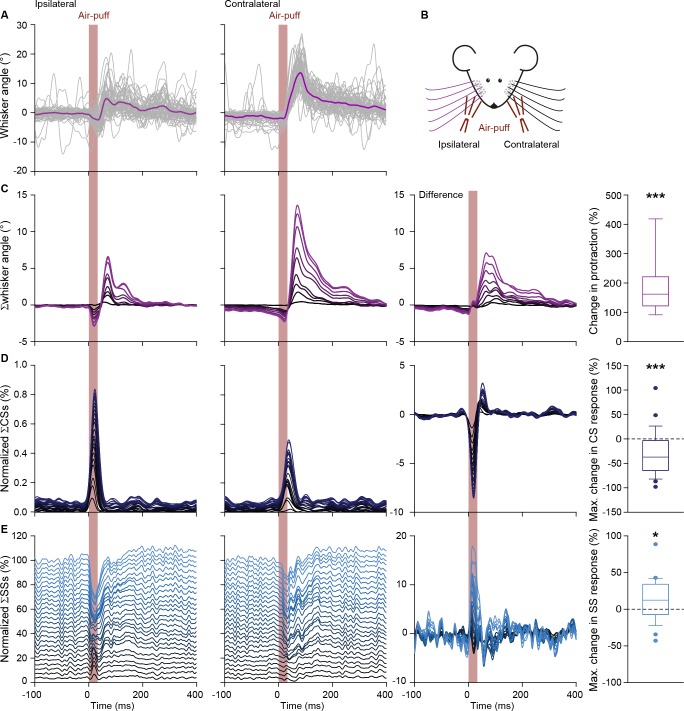
Contralateral whisker pad stimulation induces stronger whisker protraction and stronger simple spike responses.(A) Whisker traces of a representative mouse following air-puff stimulation of the ipsilateral (left panel) and contralateral (right panel) whisker pad (see scheme in B). Despite a similar strength of stimulation, the protraction of the whiskers was larger upon contralateral stimulation (cf. Figure 1—figure supplement 2). (C) Stacked line plots of the averaged whisker traces of 9 mice with the difference between the contralateral and ipsilateral stimulation depicted in the third column. (D) Complex spike responses, on the other hand, were more prominent upon ipsilateral stimulation. (E) The observation that increased simple spike firing correlates to enhanced whisker protraction (cf. Figure 4) was confirmed under these experimental conditions. *p<0.05; ***p<0.001. See also Data Source File.10.7554/eLife.38852.022Figure 5—figure supplement 3—source data 1.Data for Figure 5—figure supplement 3.